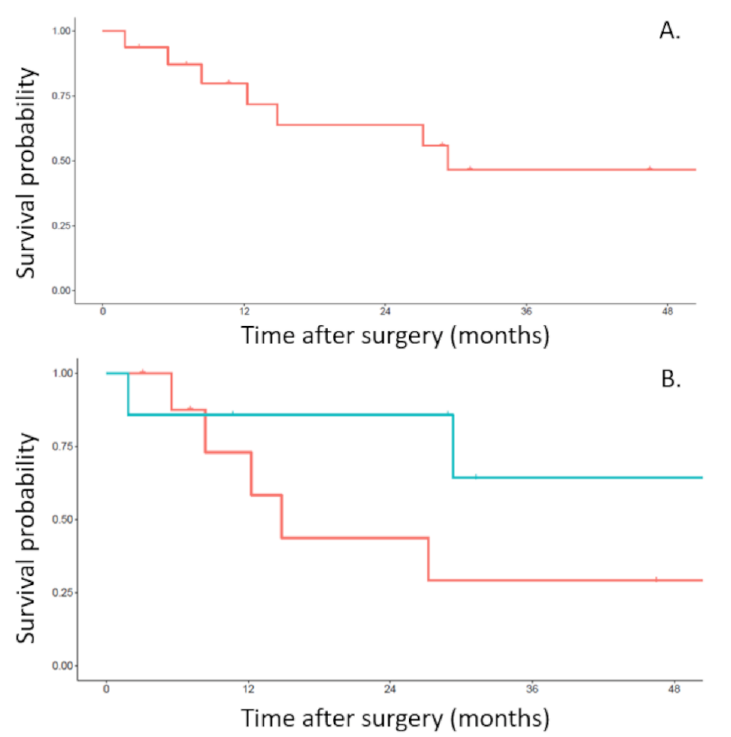
Figure 3. Disease free survival from the date of en bloc resection of the upper lobe, chest wall and vertebra. ( A ). Disease free survival of the whole population of the study. ( B ). Disease free survival related to the one-step (red line) or two-step (blue line) approach.